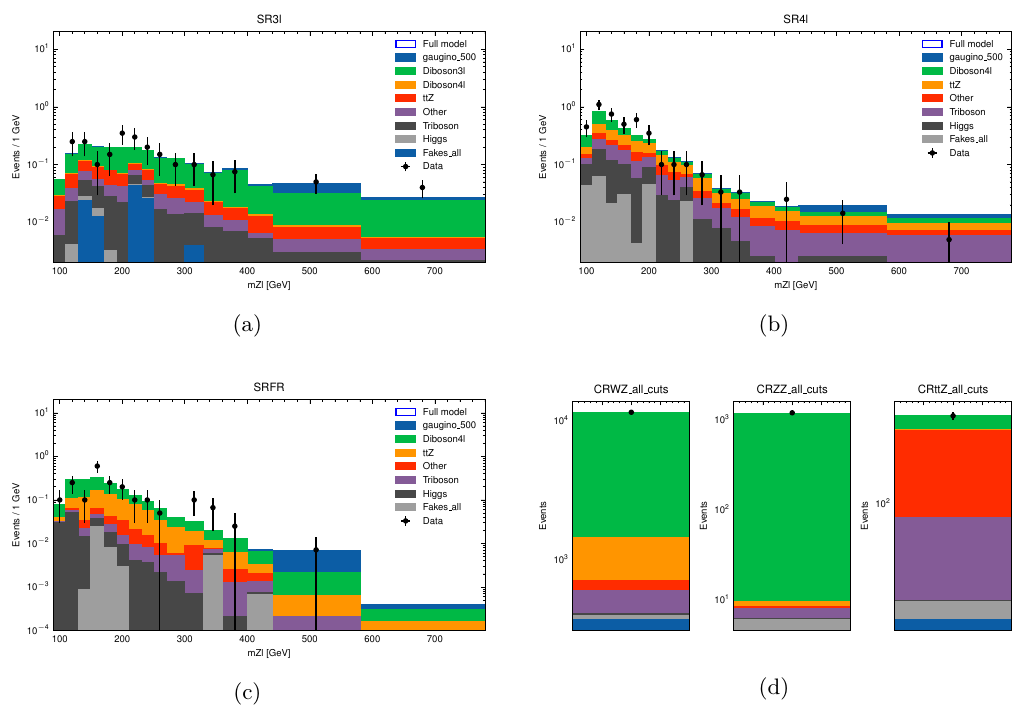
Figure 3 . Expected and observed event counts in the SR3l, SR4l and SRFR signal regions of the analysis of ref. [17], shown respectively in panels (a), (b) and (c). Panel (d) shows the analysis control regions. The signal regions are binned in the m observable, while the control regions each use a Zl single inclusive event count. The observed data (black points) is overlaid with stacked histograms (filled areas) representing the gaugino signal (dark blue) and the main background